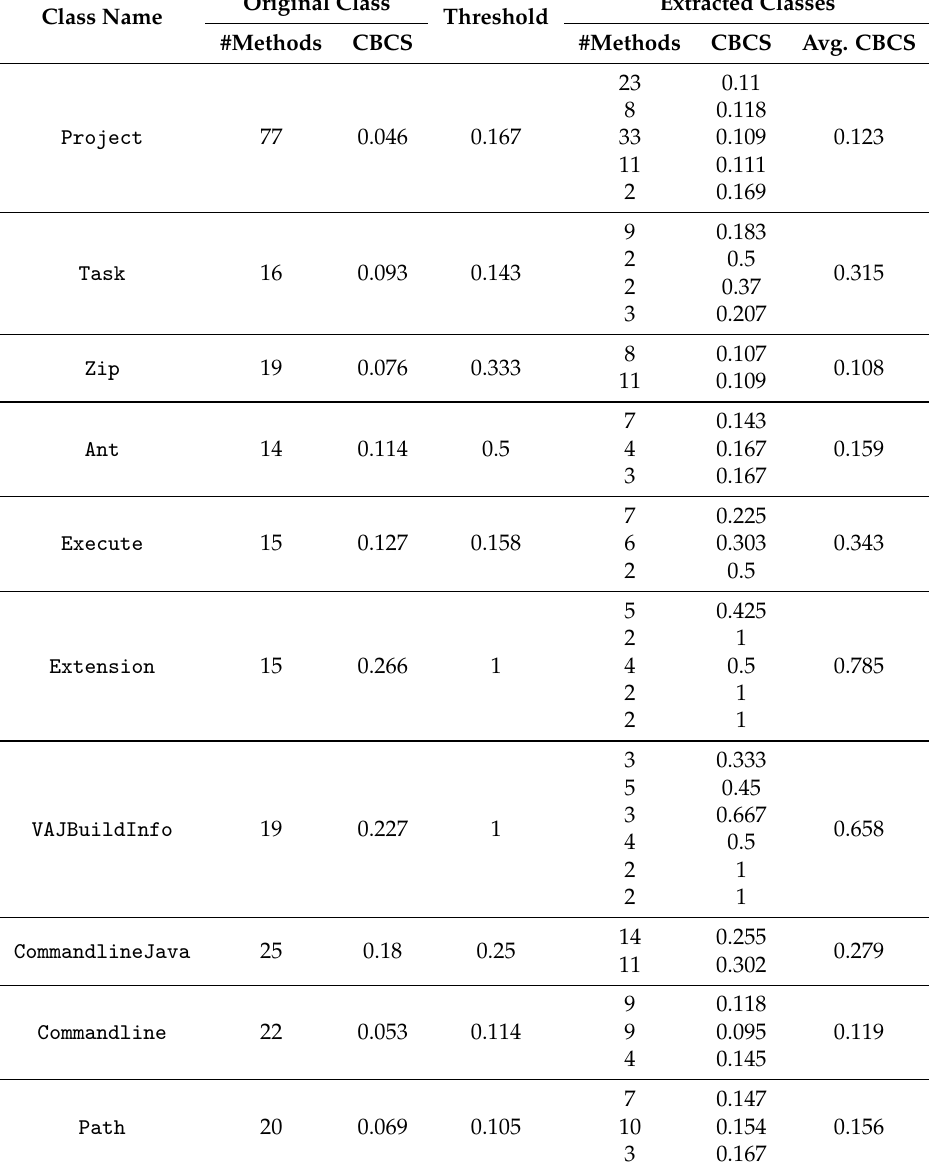
Table 5. Extracted classes suggested by our approach for the considered classes of the Ant system.